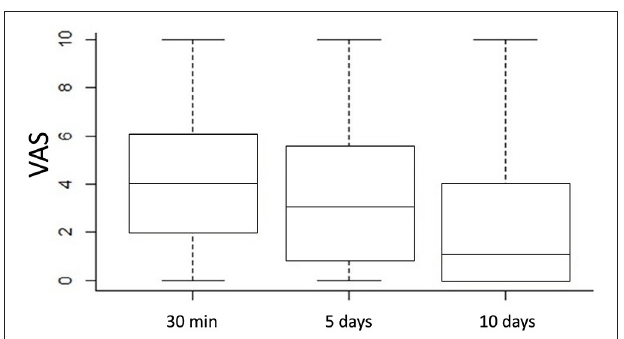
FIGURE 2 | Postoperative pain according to VAS 30min, 5 and 10 days after surgery.